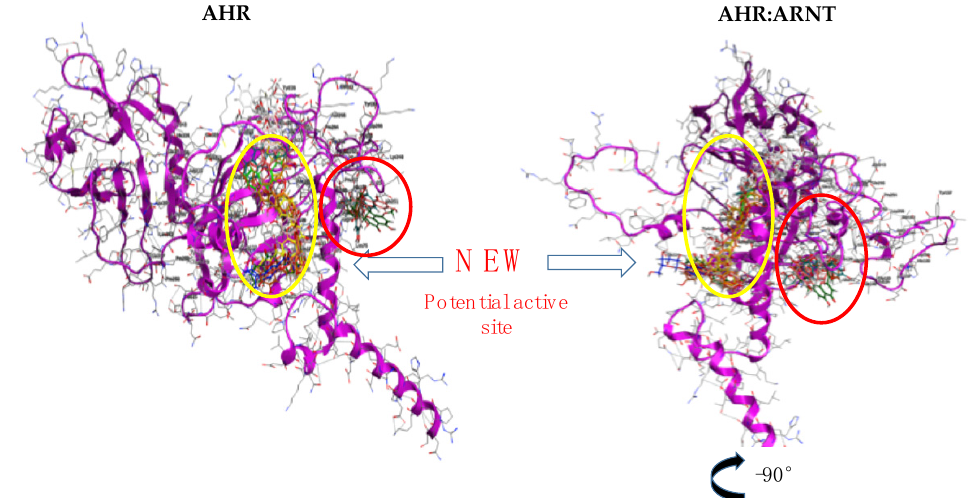
Figure 2. Interaction of flavonoids at the interface of the bHLH and PAS-A domains of AHR modeled by SwissModel. bHLH-PAS-A (yellow color) and PAS-A (Red color).